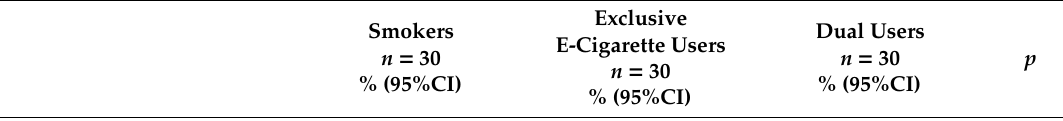
Aspects of cigarette and e-cigarette smoking based on Fagerström test for nicotine dependence